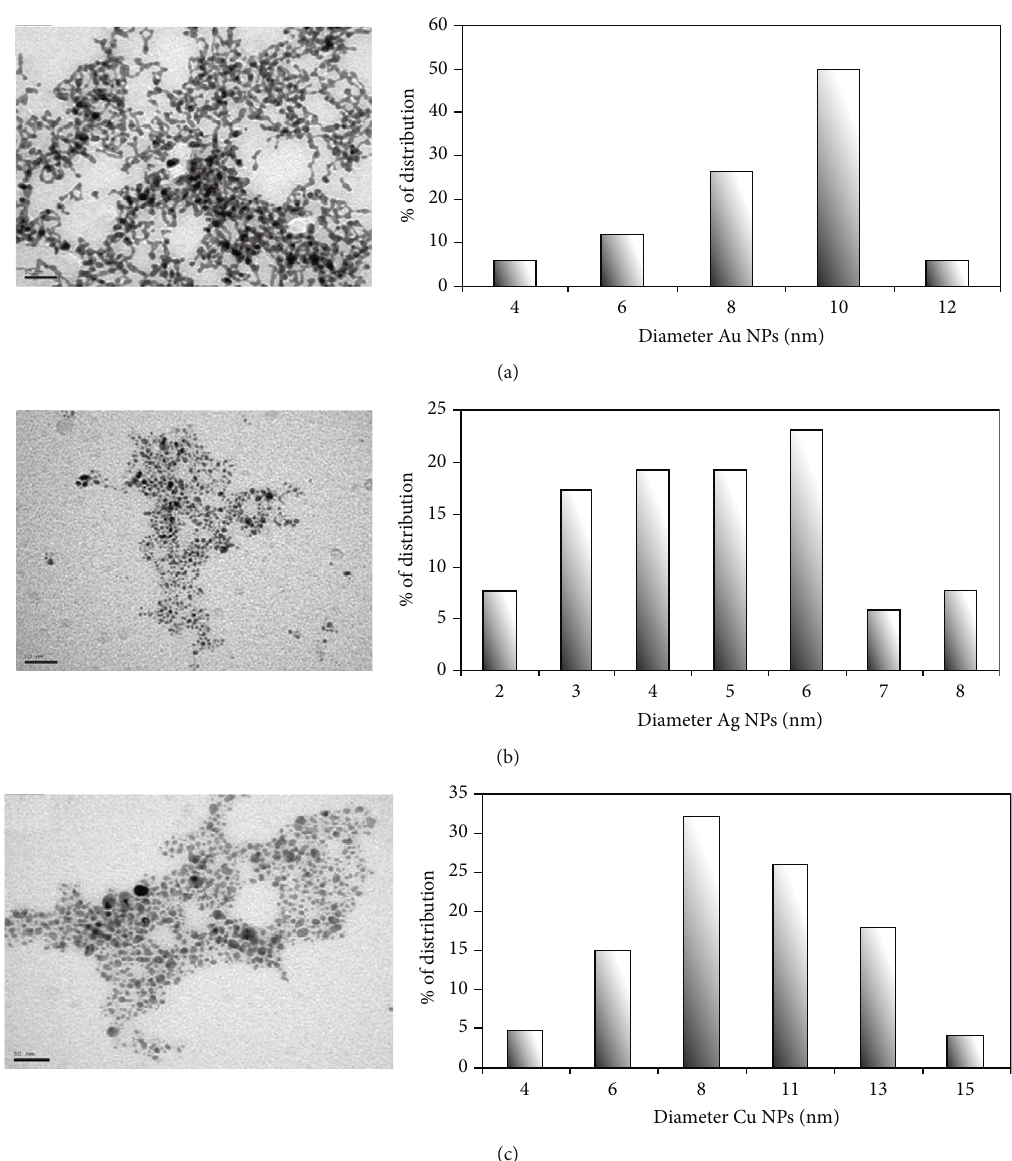
Figure 1: TEM micrograph and histogram of the size of NPs of (a) gold, (b) silver, and (c) of copper in 2-ethoxyethanol. The histograms show the distribution of the diameter measurement of solvated metal NPs in 2-ethoxyethanol. The quantum dot size is as follows: Au 10 ± 2 : 00nm , Ag 6 ± 1 : 3nm , and Cu 10 ± 2 : 39nm .